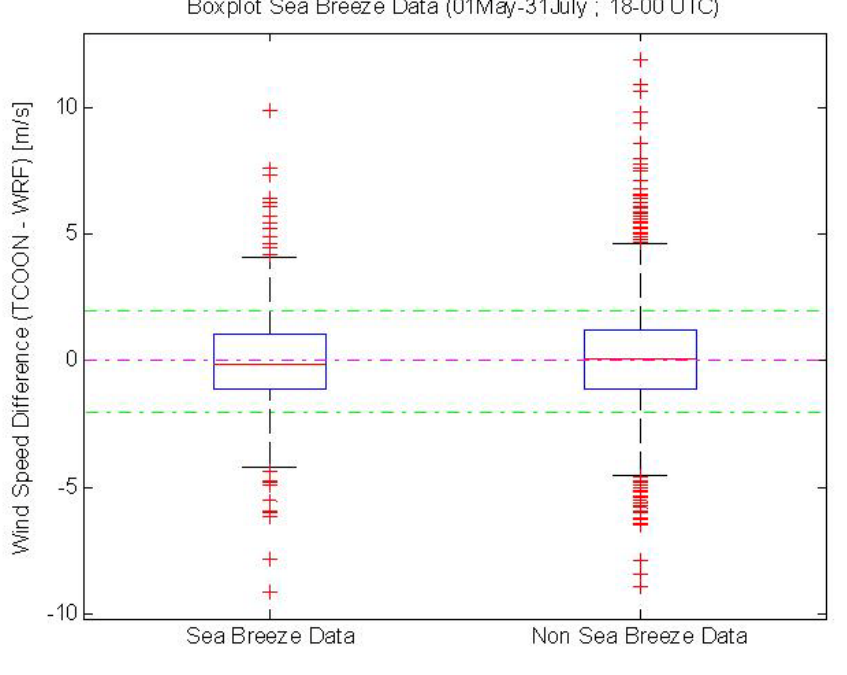
Figure 27. Boxplots for overall wind speed differences of the measured and the predicted values for both sea breeze conditions (left box of each graph) and non-sea breeze